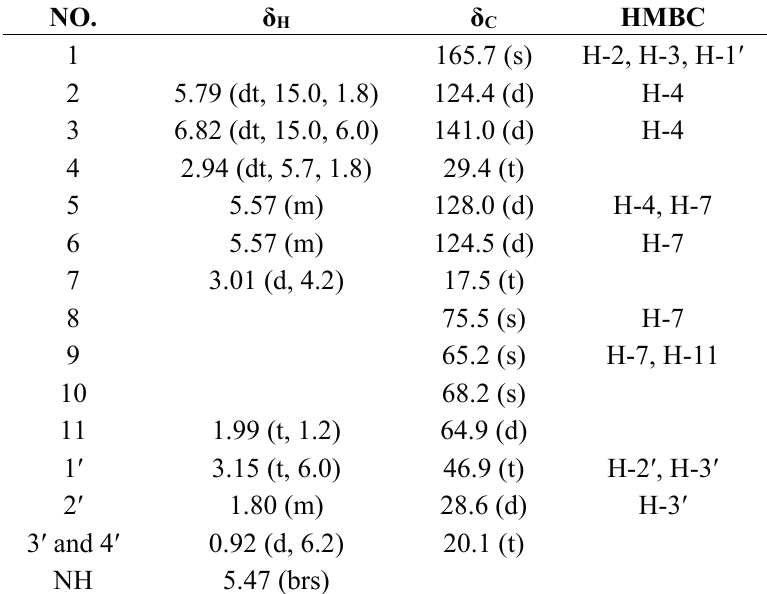
Table 1. 1 H (600 MHz) and 13 C (150 MHz) NMR assignments and HMBC correlations of 1 (CDCl 3 ).